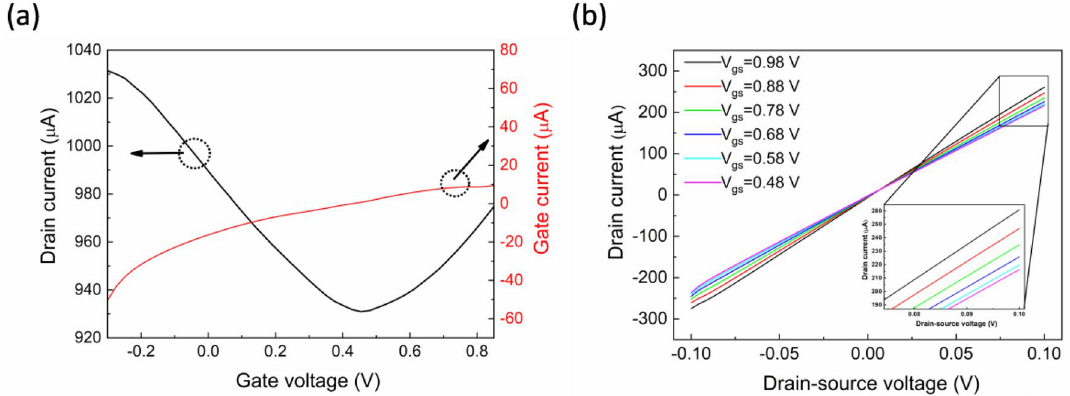
Figure 2. ( a ) Transfer and leakage current curves (V ds = 0.1 V) and ( b ) output curves of the graphene electrolyte-gated transistor. The gate voltage is varied from 0.48 to 0.98 V with an interval of 0.1 V. Magnification in